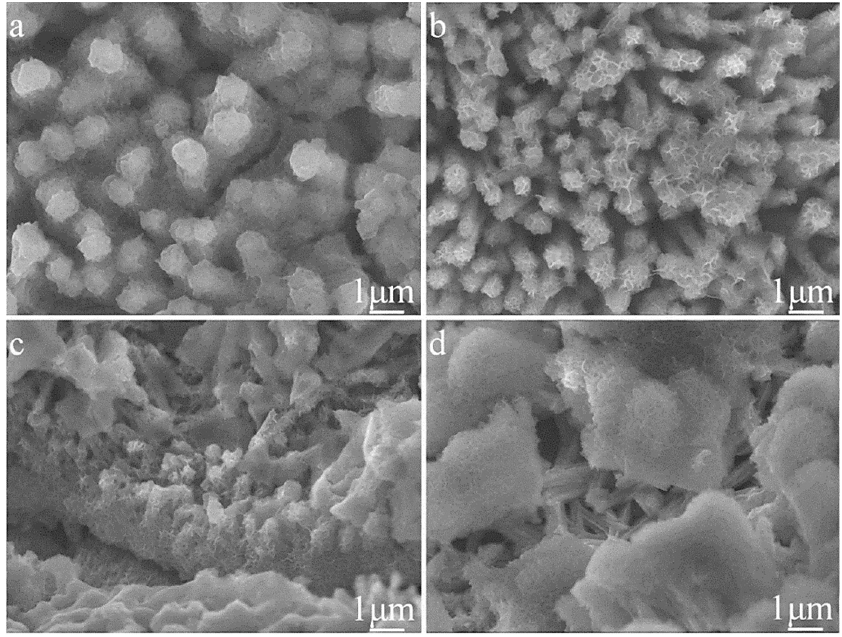
Figure 3. FESEM images of NCS@NCOH_n core-shell nanotube arrays: ( a ) n = 1, ( b ) n = 2, ( c ) n = 3, and ( d ) n = 4.